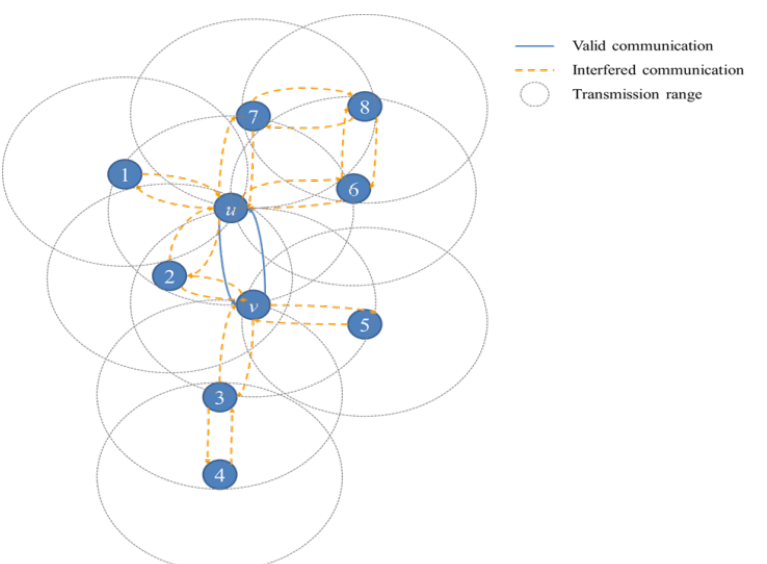
Figure 1. Interference range when Node u sent a message to Node v